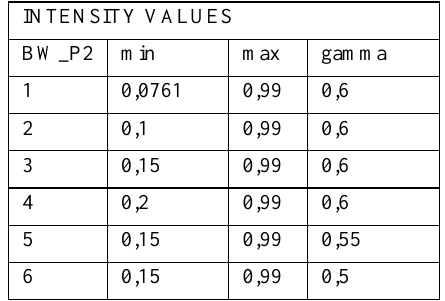
Table 3. Intensity values data tested during the post-processing in greyscale visualization (sample